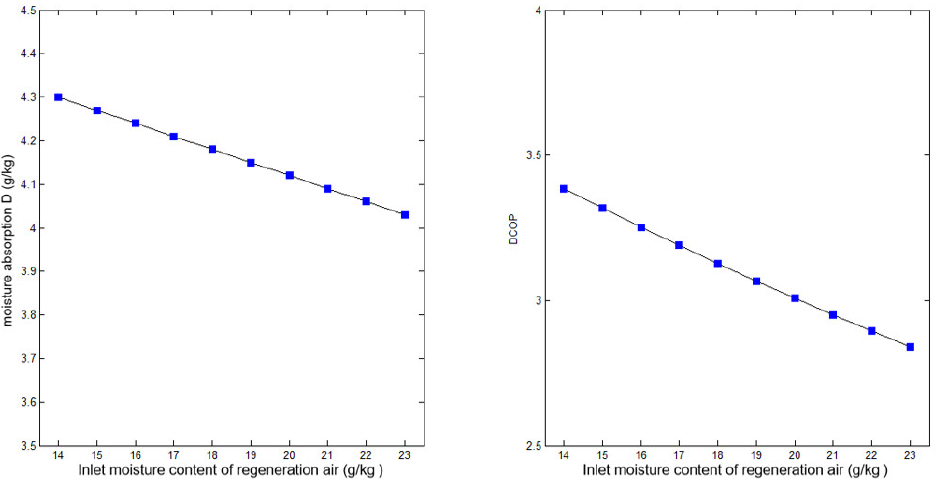
Figure 16. Effect of moisture content of regenerated air inlet on moisture absorption D and DCOP.